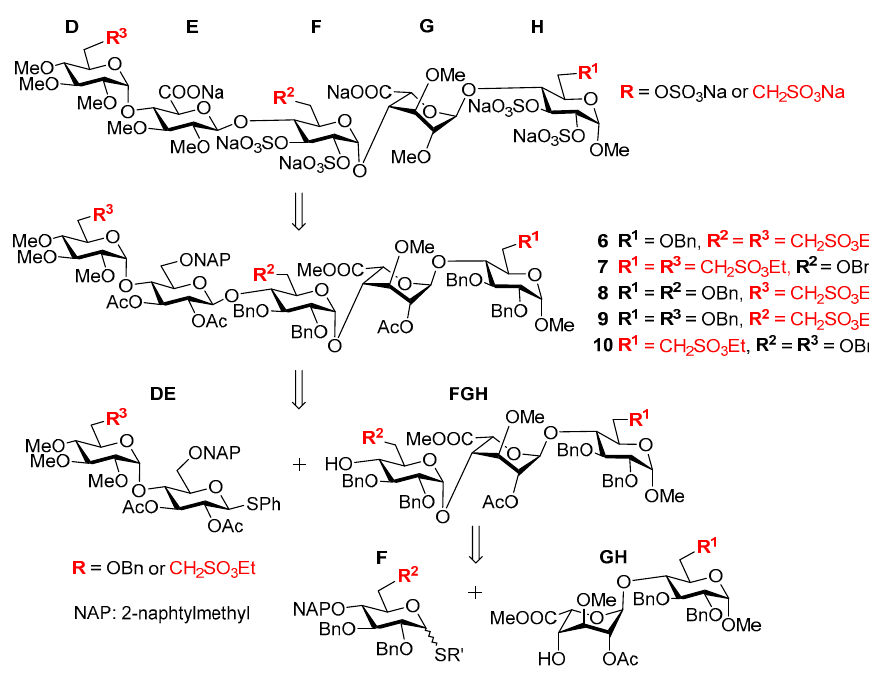
Figure 2. Retrosynthetic analysis for modular [2 + 3] block syntheses of the targeted pentasaccharide sulfonic acids 6 – 10 .